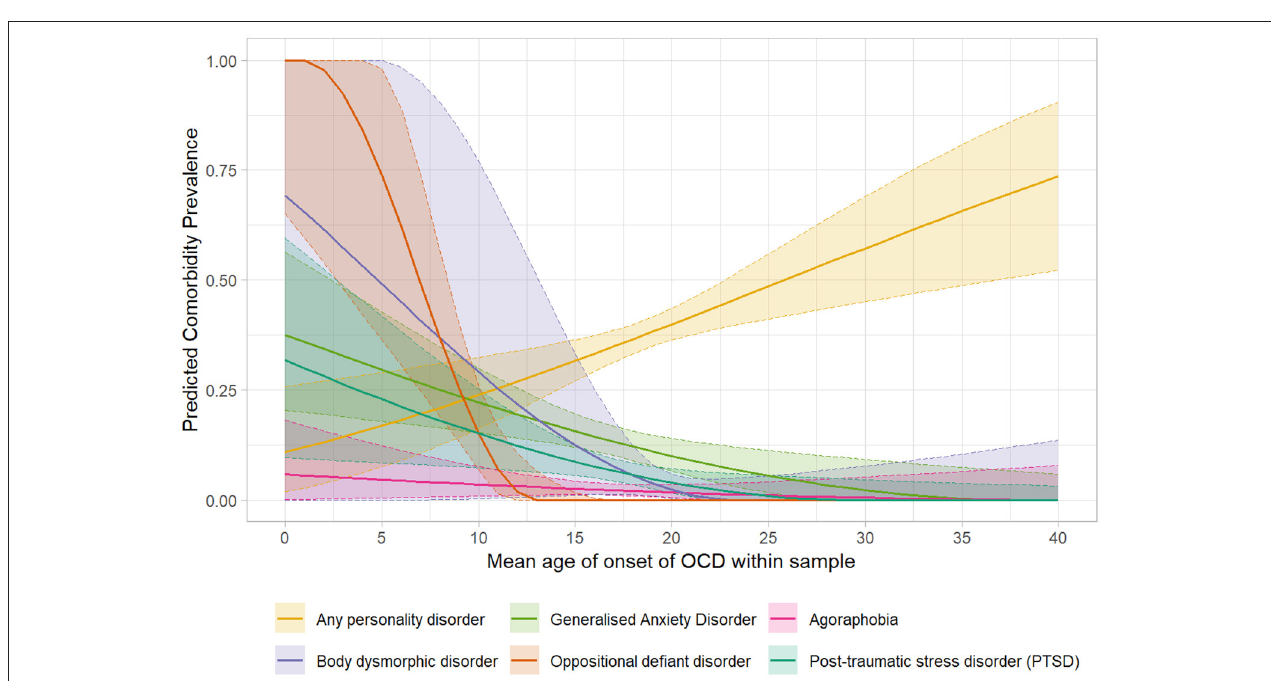
FIGURE 4 | Significant meta-regressions by mean age at assessment of samples. Rates of MDD, Substance use & Panic Disorder are higher in older samples, whereas rates of Schizophrenia/Psychosis & GAD are higher in younger samples.